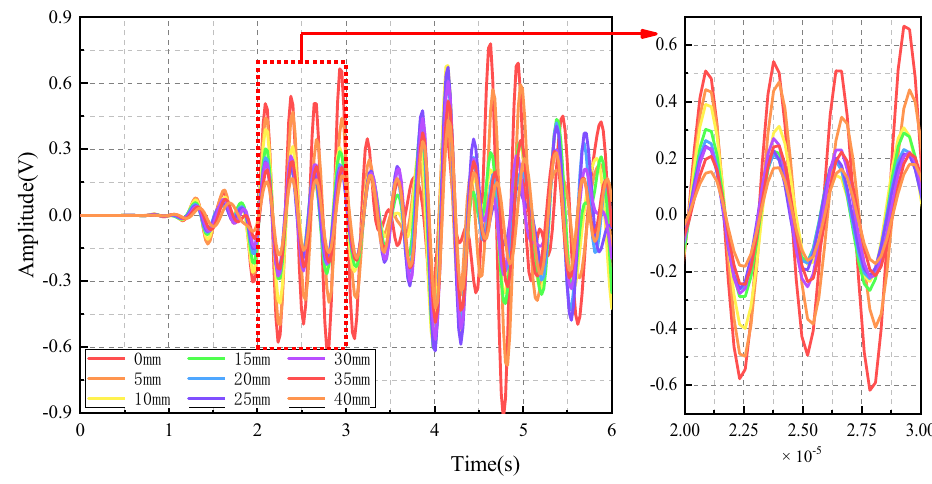
Figure 11. Time domain signal diagram received by PZT sensor (30 kHz).